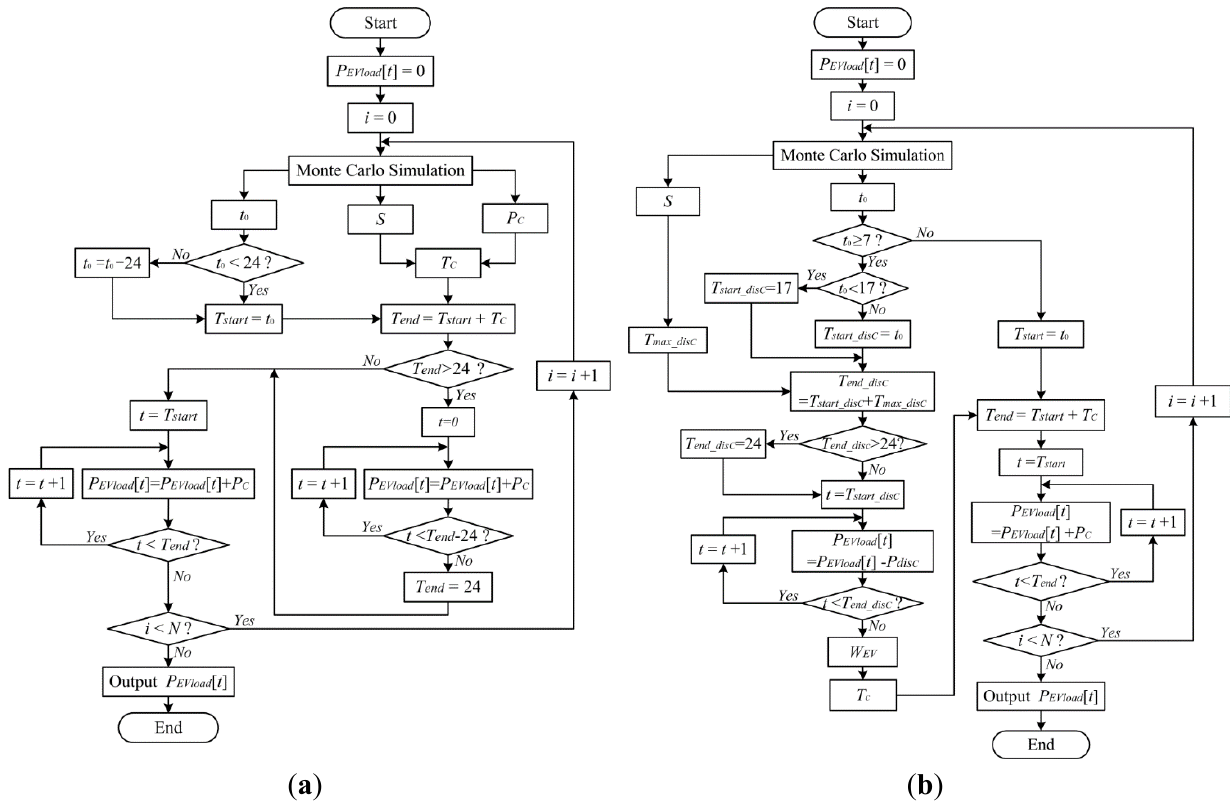
Figure 1. ( a ) The computational flowchart of the daily load of EVs under autonomous charging mode; ( b ) The computational flowchart of the daily load of EVs under coordinated charging/discharging